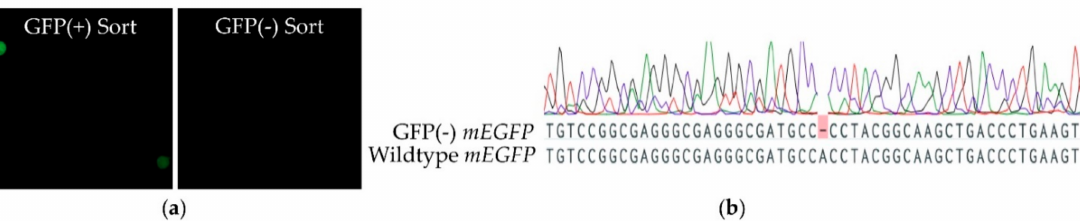
Figure 7. Knock-out targeting pias1 and pias2 in CHSE-EC cells. ( a ) Sorting of GFP-positive (+) and GFP-negative (-) cells; ( b ) genotype of GFP(-)